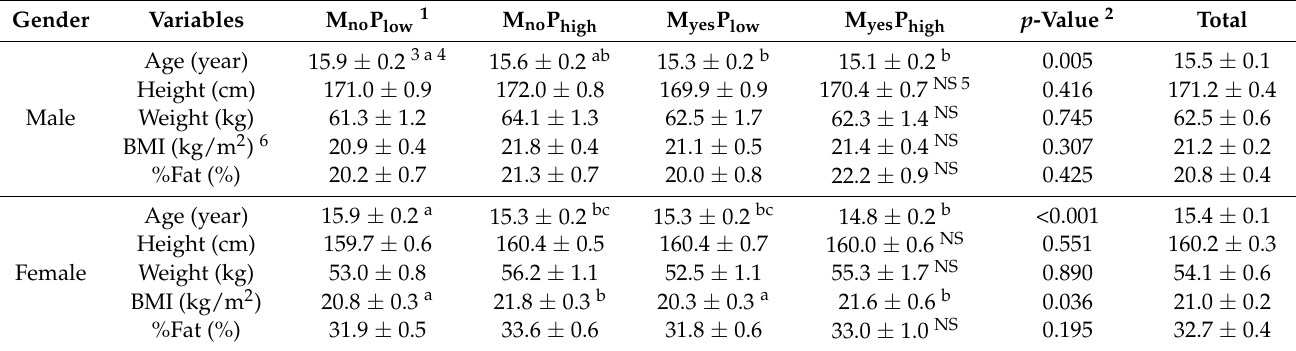
Table 3. Physical characteristics of